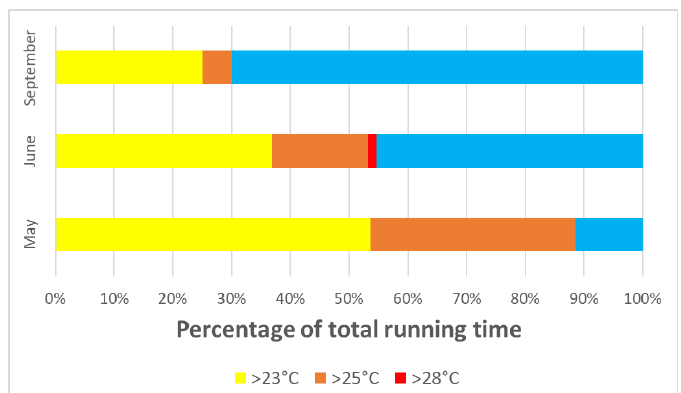
Figure 12. Percentage of hours above threshold values for internal temperatures in the lecture room on the first floor (May–September 2017).